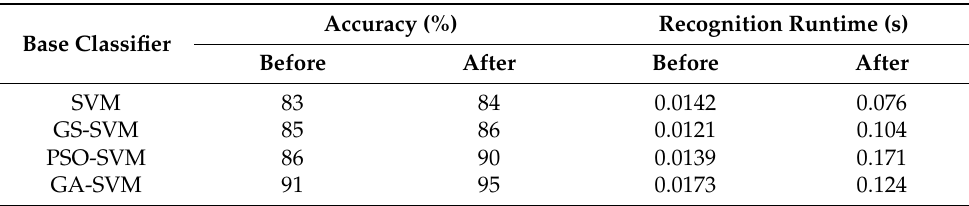
Table 4. Coal gangue recognition accuracy and recognition runtime of different base classifiers before and after adaptive